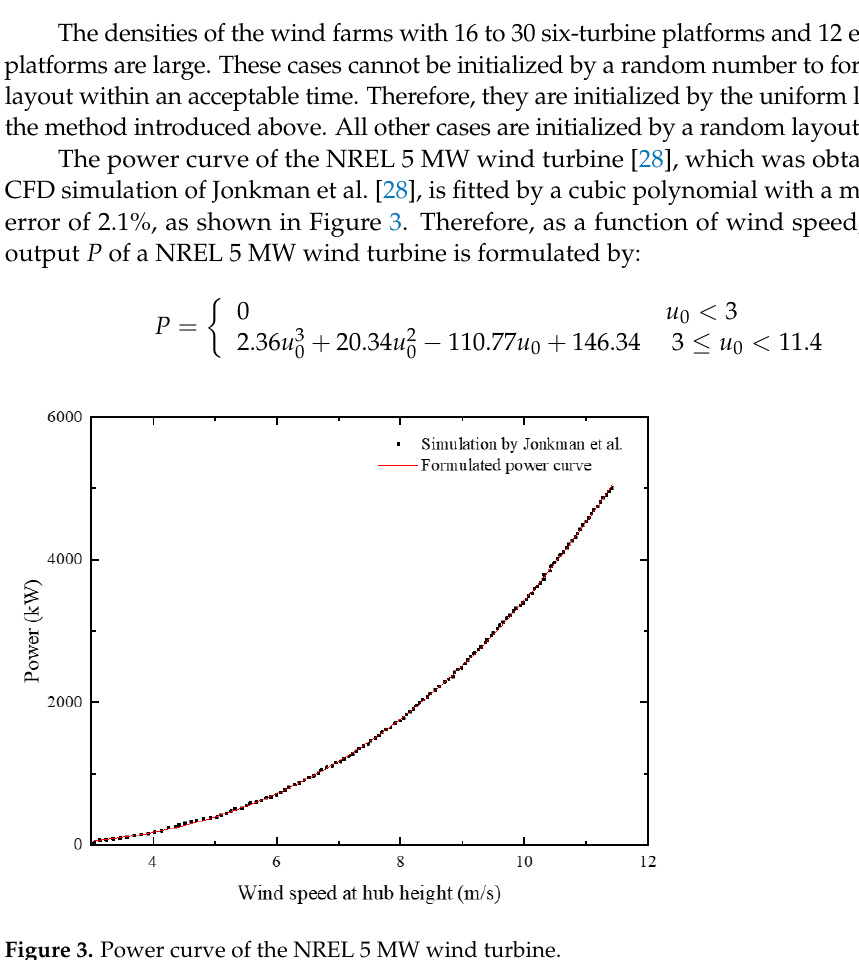
Table 3. Parameters for optimization.